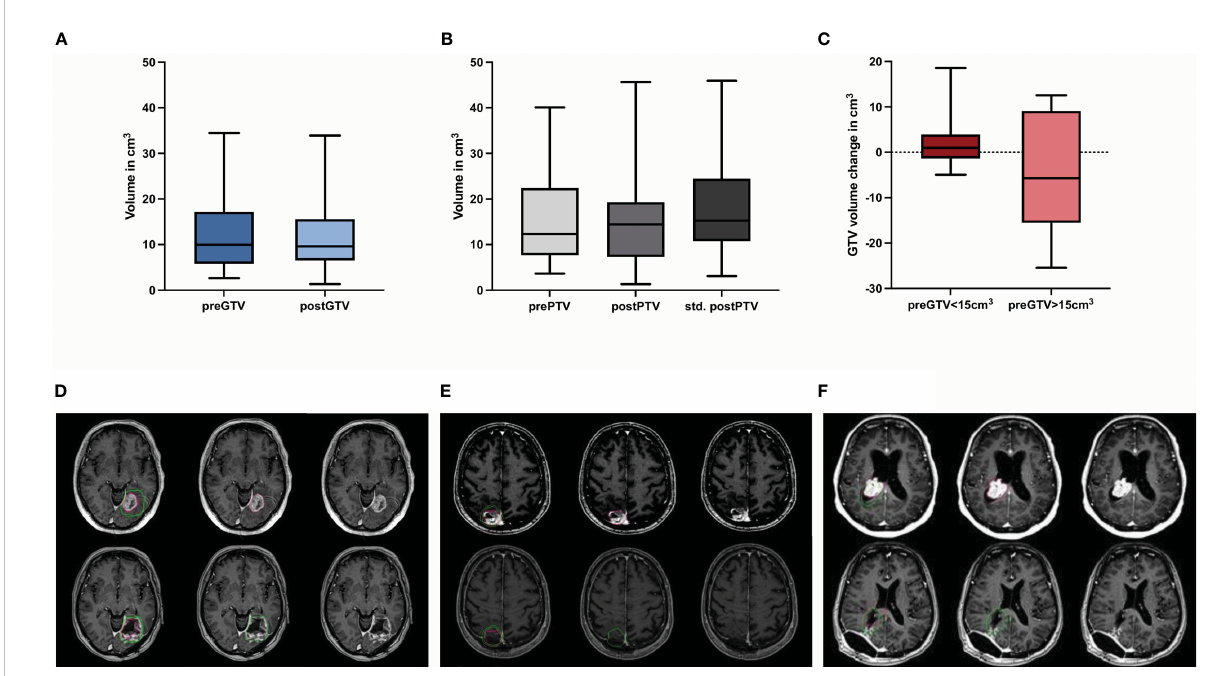
FIGURE 4 Quanti fi cation of the preoperative (pre) and postoperative (post) (A) gross tumor volume (GTV) and (B) planning target volume (PTV) including hypothetical standardized PTV with a 2 mm margin to post-GTV (n = 30; no signi fi cant differences, Wilcoxon test), (C) shows the volume change of binarized pre-GTV volumes depending on size with a cut-off of 15 cm 3 , (n = 22 for pre-GTV < 15.0 cm 3 and n = 8 for pre-GTV > 15.0 cm 3 ; no signi fi cant differences, Mann-Whitney-U-test.) Boxplots represent the interquartile range, the thicker line inside the boxes the median, and the whiskers indicate the range from minimum to maximum. Representative case presentations with one deep (D) one super fi cial (E) and one intraventricular (F) metastasis from non-small cell lung carcinoma shown in axial MRI images with contrast demonstrating comparison of GTV in red for preoperative metastases and in green for the resection cavity. In these cases, an increase in post-GTV compared with pre-GTV can be seen, which was 227.3% in (D) , 86.6% in (E) , and 19.3% in (F) .